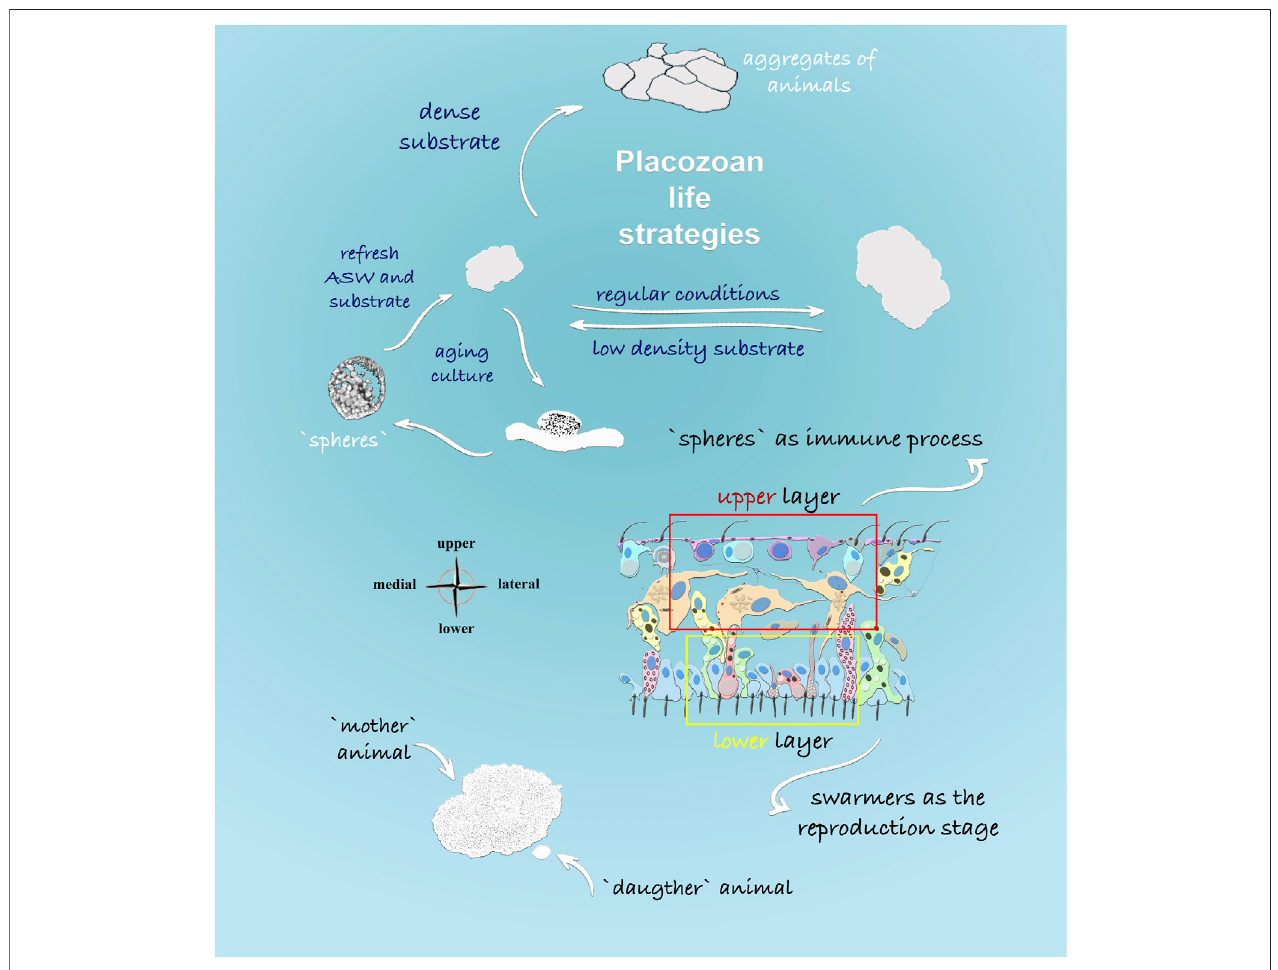
FIGURE 9 | Life Strategies in Placozoa: Schematic representation of feeding and reproductive stages described in this study. The density of food substrate predominantly determines formations of different morphological stages. Dense algal substrate led to the formation of aggregates from multiple animals ( “ social ” feeding behavior). In aging culture, the formation of specialized spherical structures was observed from the upper cell layer of placozoans, and it was shown that spheres could harbormultiplebacteria.Incontrast,theformationofsmalljuvenileanimalsor “ swarmers ” mighthavedifferentetiologyanddevelopmentfromthelowercelllayer,as shown in the cross-section of Trichoplax